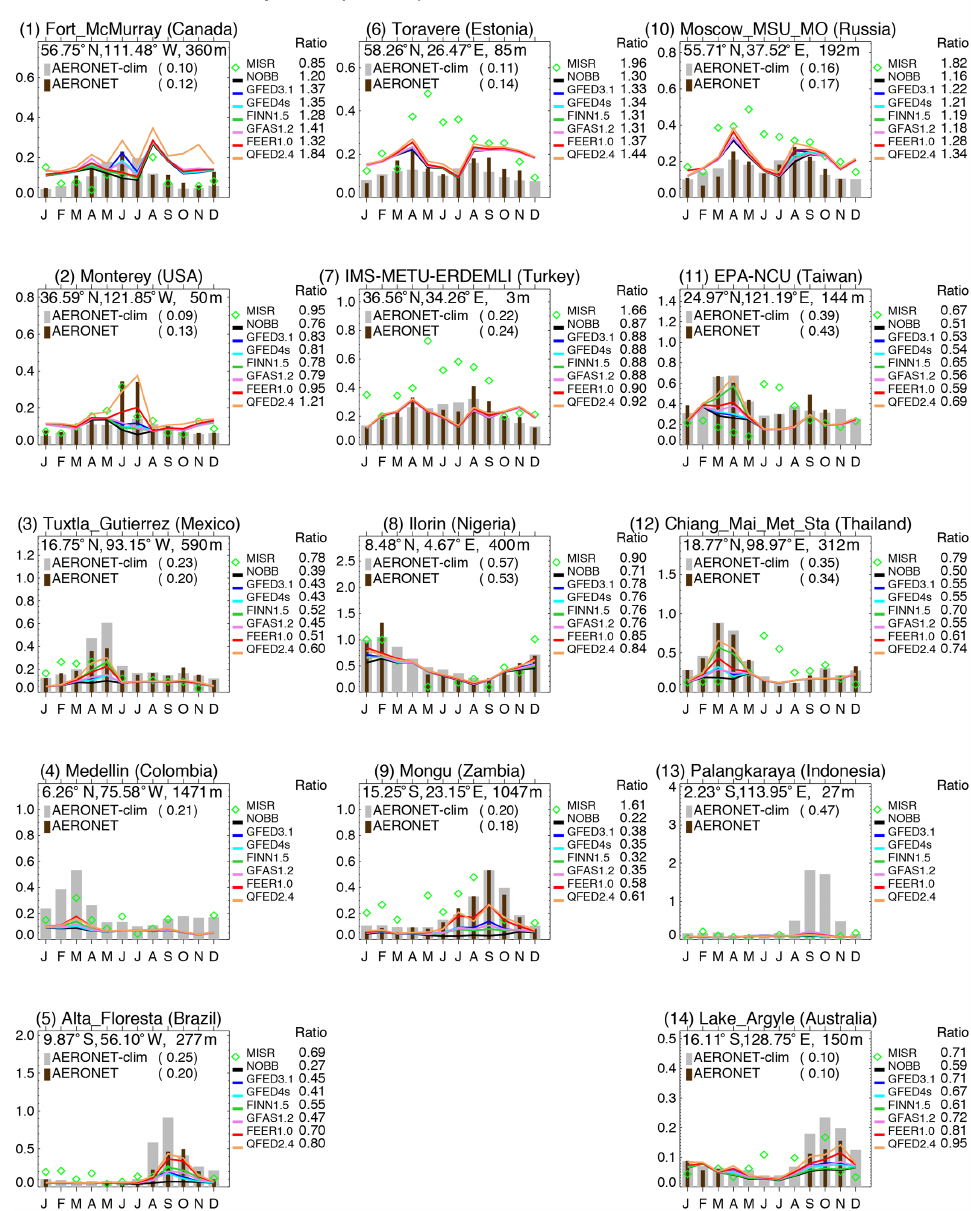
Figure 7. Monthly variation in AOD (at 550nm wavelength) for 2008 over 14 AERONET sites selected from the respective 14 regions (with the country of each site indicated in parentheses). The climatology of AERONET AOD (i.e., AERONET-clim) is represented by thick light gray bars and the monthly mean AERONET AOD for 2008 by thin brown bars, with their corresponding annual mean values shown in paren- theses. MISR monthly mean AOD at 558nm is represented by the green diamonds, and the seven GEOS experiments with different biomass burning emission options are represented by the lines in different colors. The corresponding annual ratios (ratio of model / AERONET) listed on the right-hand side of each panel are estimated by averaging over monthly